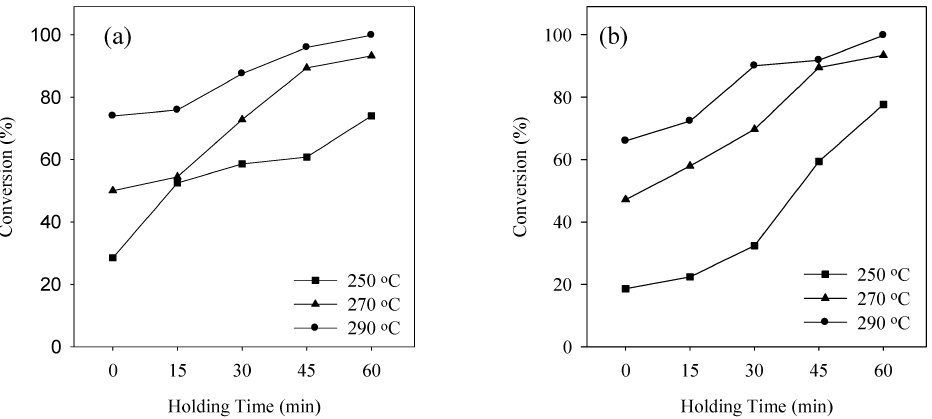
Figure 2. Conversion at various reaction temperature using ( a ) SCM and ( b ) SCE for waste pig fat to alcohol ratio of 1:1.5.